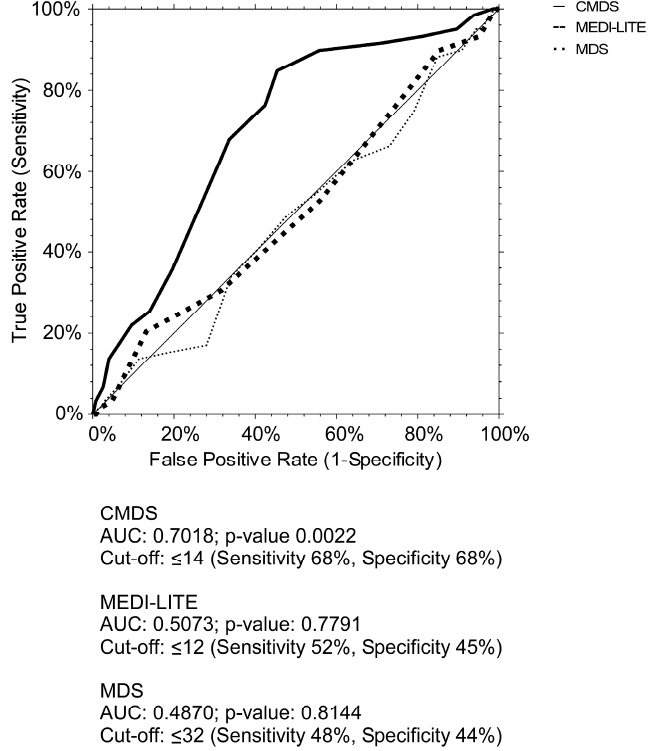
Figure 4. ROC curve of CMDS, MEDI-LITE, and MDS for increased waist circumference. ROC curves characteristics of CMDS, MEDI-LITE score, and MDS for increased WC according to MetS IDF definition ( ≥ 94 cm in men and ≥ 80 in